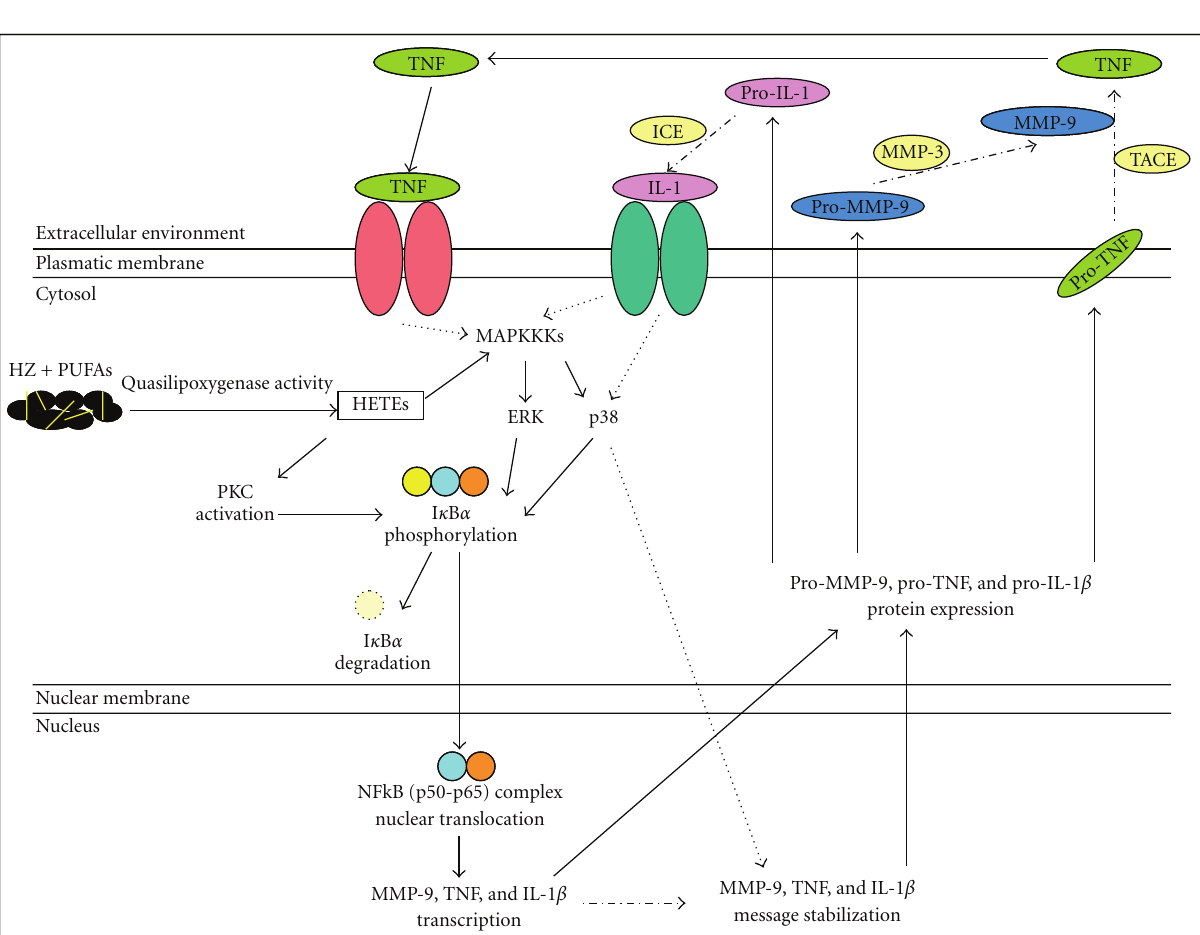
Figure 3: Putative mechanisms through which HZ and 15-HETE might promote NF-kappaB-controlled gene expression of MMP-9 and related